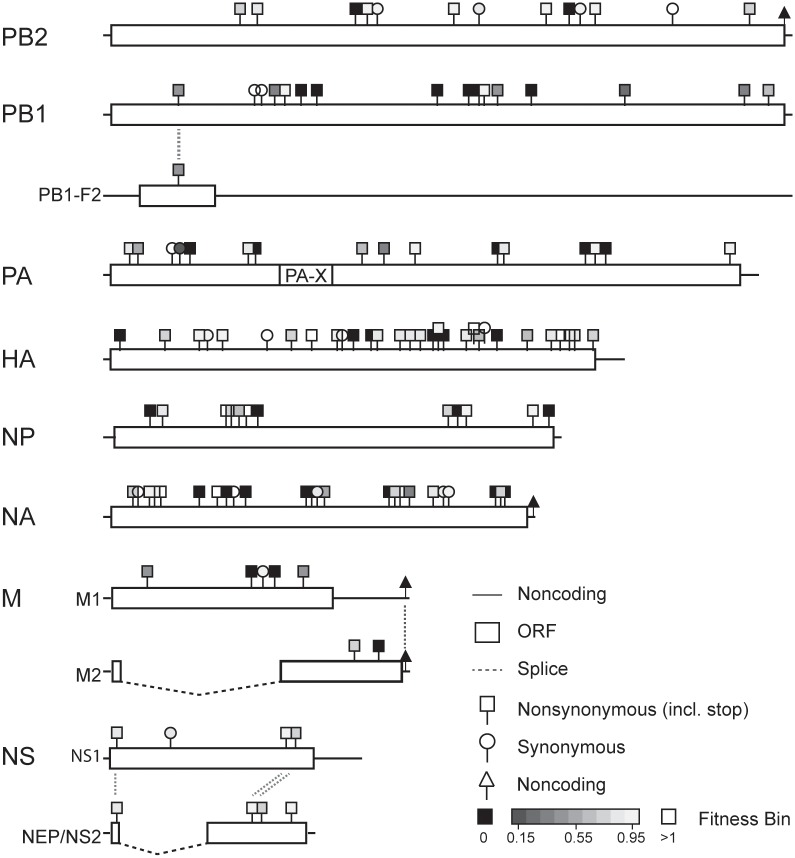
Location and fitness for all mutations.Each mutation in Tables 1 and 3 is shown in its reading frame(s) with substitution type (nonsynonymous, synonymous, or noncoding) and fitness (see legend).